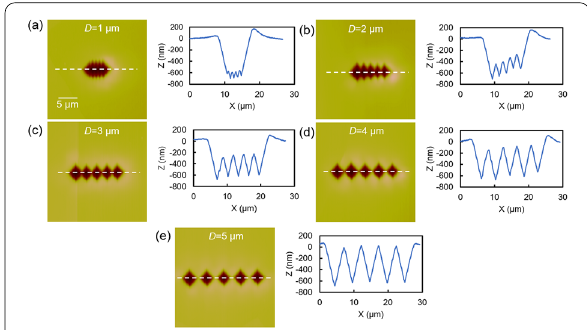
Figure 10 AFM images and the corresponding cross-sections of the experimental results for the one array indentations with the rotation angle of 0° and the spacings of a 1 μm, b 2 μm, c 3 μm, d 4 μm and